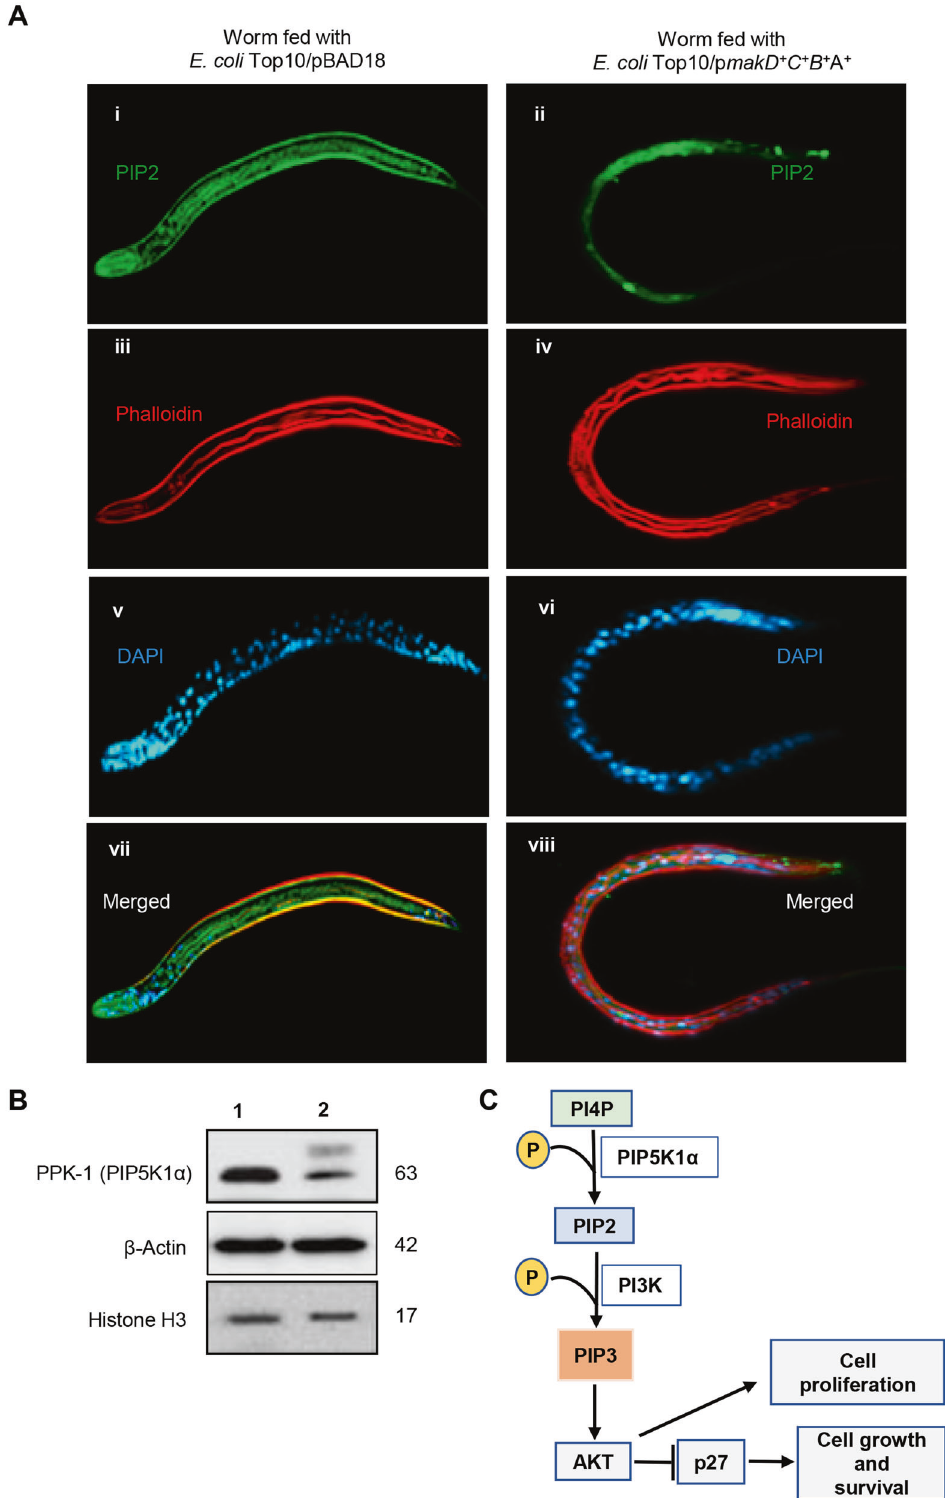
Fig. 1 MakA-expressing bacteria inhibit PIP5K1 α phospholipid signalling in C. elegans . A C. elegans were fed with E. coli Top10/pBAD18 or E. coli Top10/ pmakDCBA . PIP2 levels was assessed by confocal microscopy using anti-PIP2 mouse antibody. Nuclei were counterstained with DAPI (blue) and actin fi laments with phalloidin (red). B Western blot analysis of levels of PPK-1 (PIP5K1 α ortholog) in total cell lysates of worms fed with E. coli Top10/pBAD18 or E. coli Top10/ pmakDCBA . C Schematic representation of phospholipid signalling in human host cells.